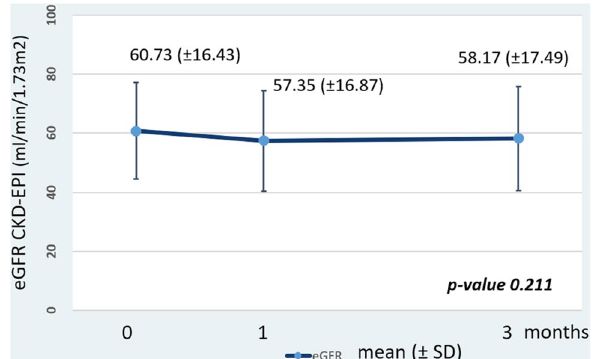
Figure 5. Allograft function by eGFR CKD-EPI at before conversion, one month, and 3 months after conversion; p-value by repeated ANOVA. (eGFR CKD-EPI; estimated glomerular filtration rate by chronic kidney disease epidemiology collaboration equation).